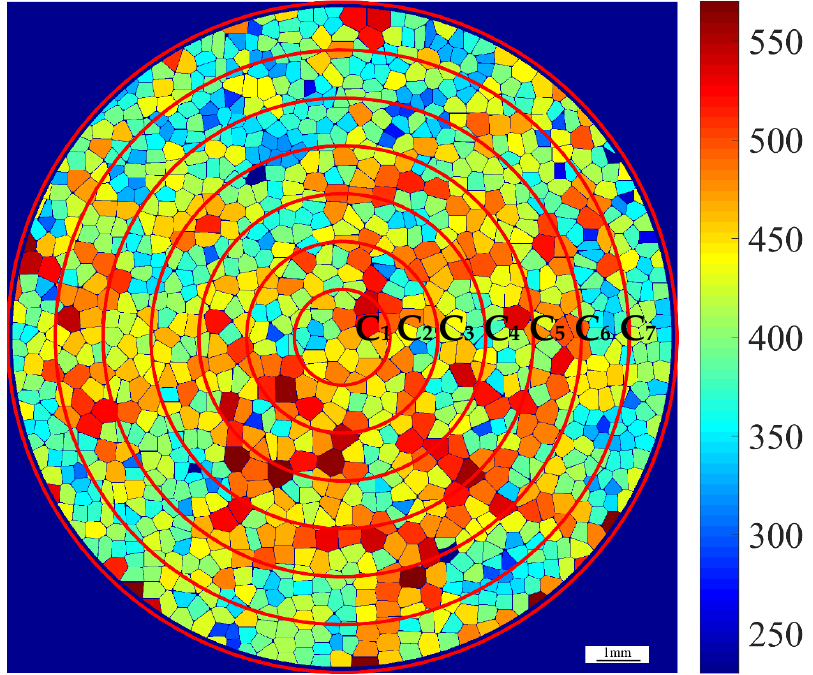
Figure 13. The 7 rings which are equally spaced from the local PDAS distribution of HT901; C1 is the center of HT901, and C7 is the edge of the sample.